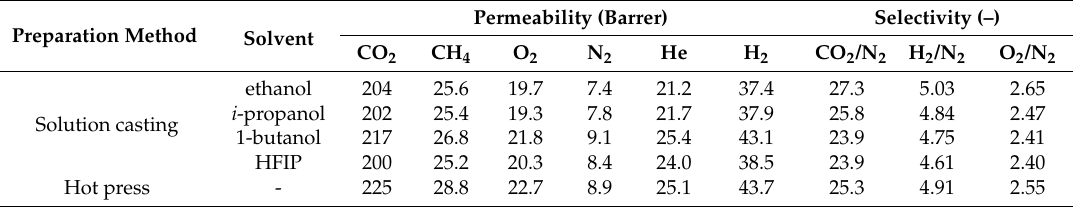
Table 6. Gas permeability of Pebax ® 2533 at 25 ◦ C. ‘As prepared’ films (T0